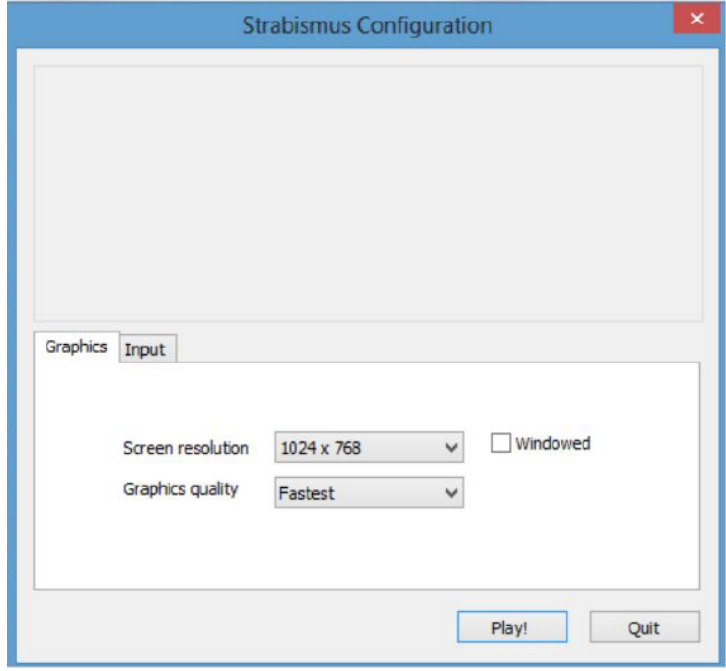
Figure 3. Choice of the resolution in the application used in the treatment described in this